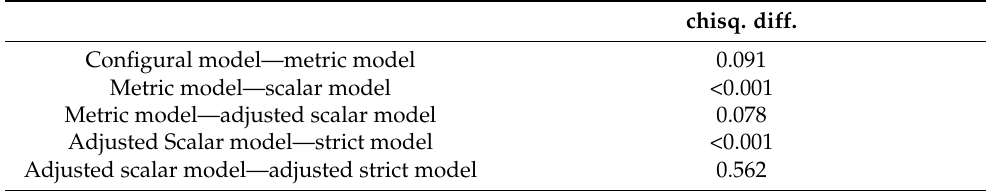
Table 5. Differences between chi-square statistics for religiosity groups.